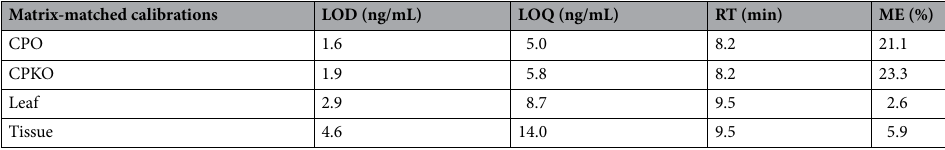
Table 1. Limit of detection (LOD), limit of quantification (LOQ), retention time (RT) and percentage of matrix effect (ME %) of CPO, CPKO, leaf, and tissue of oil palm.